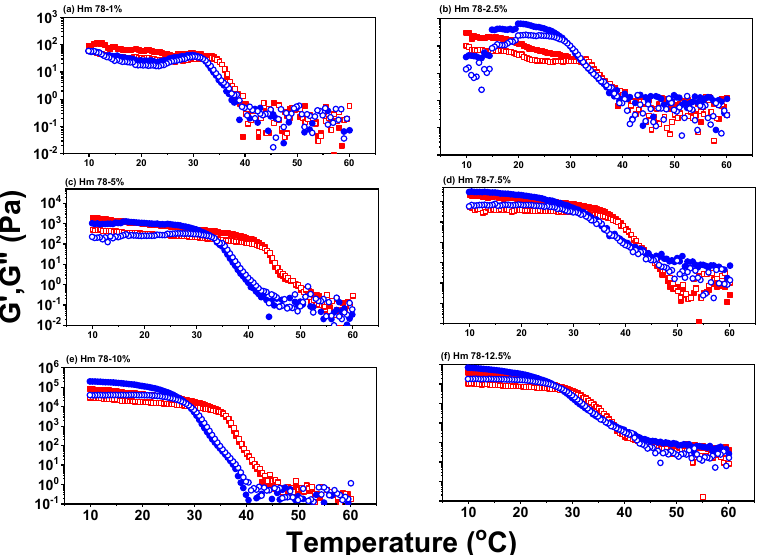
Figure 7. Variations in storage ( G ’, filled symbol) and loss ( G ”, open symbol) moduli for Hm78 solutions at concentrations of ( a ) 1%, ( b ) 2.5%, ( c ) 5%, (d) 7.5%, ( e ) 10%, and ( f ) 12.5% as a function of temperature at a frequency of ω = 10 rad/s and a strain amplitude of γ = 0.1%. Symbols ( ■ , □ ) and ( ● , ○ ) are for heating and cooling sweeps, respectively.